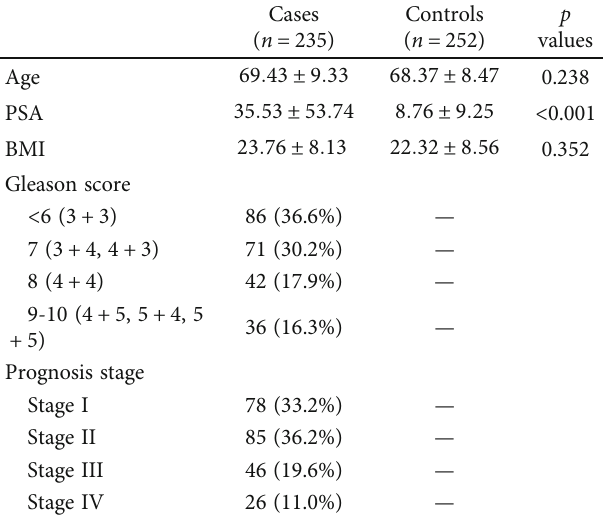
Table 2: Demographic characteristics of study